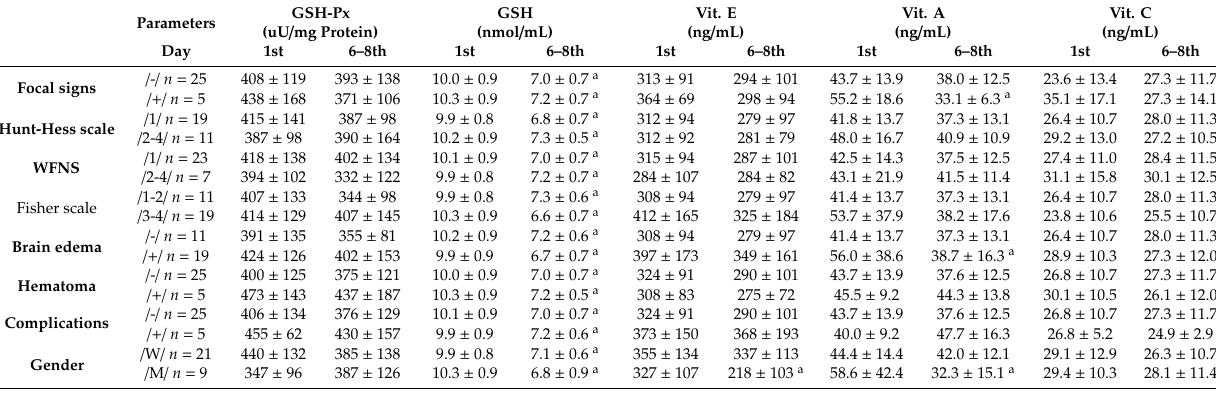
Table 1. The mean plasma concentration of antioxidants in SAH-patients with regard to neurological conditions and gender; a p < 0.05 in comparison with patients on the first day after SAH.